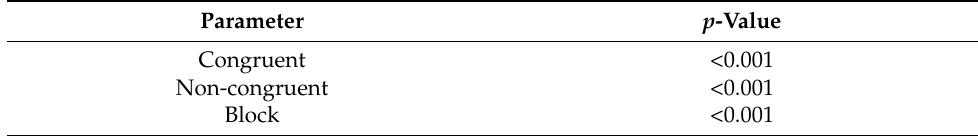
Table 3. ANOVA p -values between NED and Congruent, Non-Congruent and